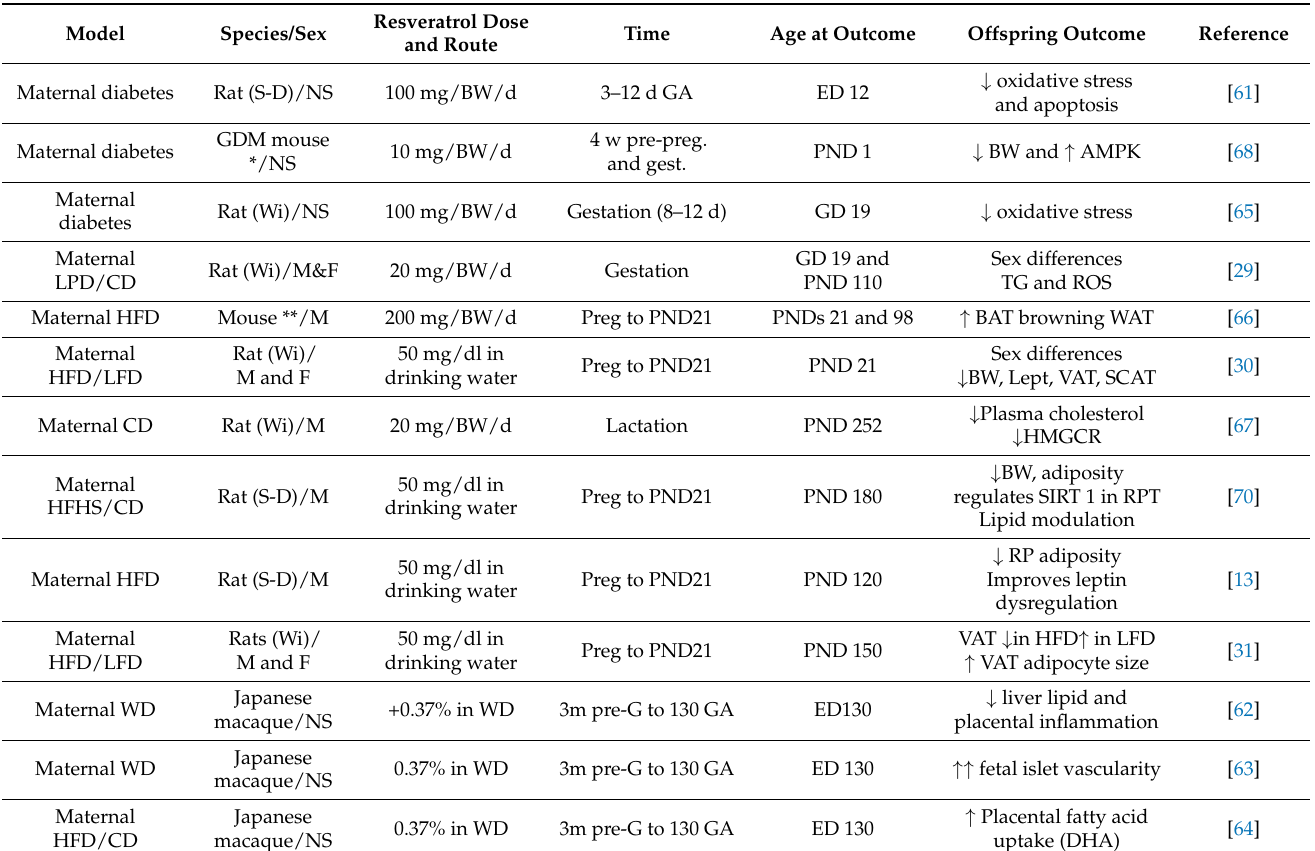
white adipose tissue. Wi: Wistar rat. WD: Western diet. * Genetic gestational diabetes model C 57 BL/KsJ-Lepdb/+ (db/+). ** C57BL/Gj mice. ↓ decreases, ↑